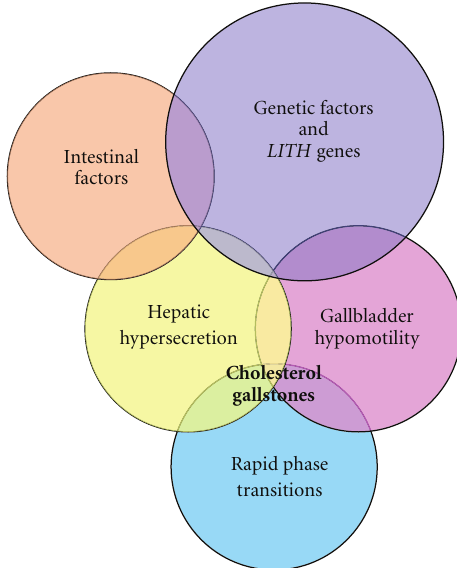
Figure 2: Venn diagram of five primary defects: genetic factors and LITH genes, hepatic hypersecretion, gallbladder hypomotility, rapid phase transitions, and intestinal factors. The hypothesis proposed is that hepatic cholesterol hypersecretion into bile is the primary defect and is the outcome in part of a complex genetic predisposition. The downstream e ff ects include gallbladder hypomotility and rapid phase transitions. A major result of gallbladder hypomotility is alteration in the kinetics of the enterohepatic circulation of bile salts, resulting in increased cholesterol absorption and reduced bile salt absorption that lead to abnormal enterohepatic circulation of bile salts and diminished biliary bile salt pool size. Not only does gallbladder hypomotility facilitate cholesterol nucleation/crystallization, but also it allows the gallbladder to retain cholesterol monohydrate crystals. Although a large number of candidate Lith genes have been identified in mouse models, the identification of human LITH genes and their contributions to gallstones require further investigation. Reproduced with modifications and with permission from